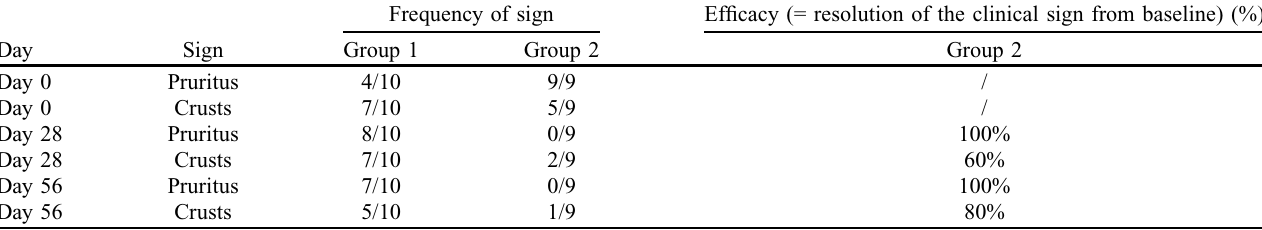
Table 3. Resolution of the clinical signs related to Sarcoptes scabiei var. canis. Frequency of sign Efficacy (= resolution of the clinical sign from baseline)